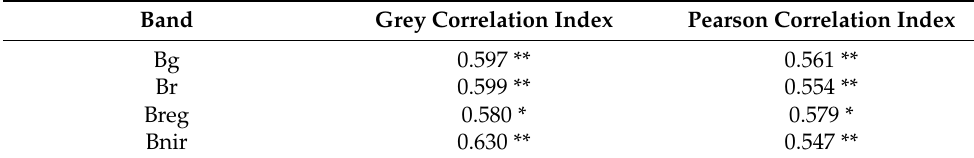
Table 4. Correlation coefficient between soil salinity and UAV’s band.